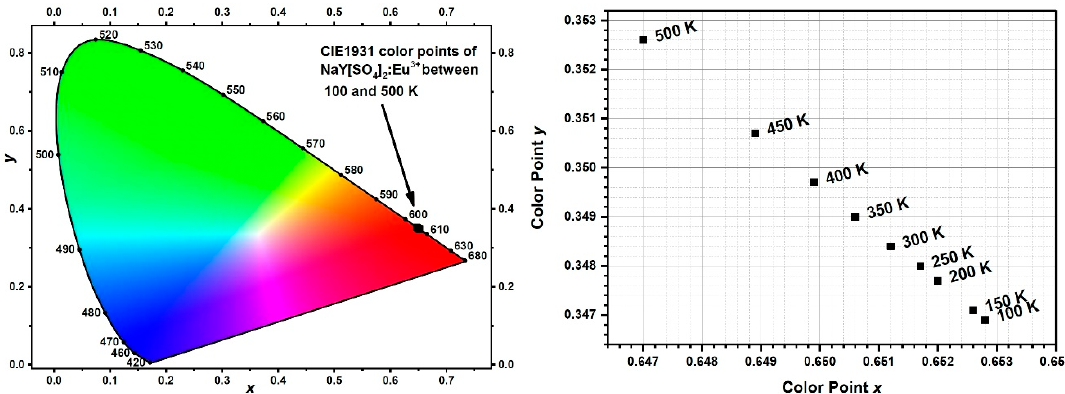
Figure 15. Temperature-dependent CIE1931 color points of the anhydrous NaY[SO 4 ] 2 :Eu 3+ between 100 and 500 K upon 395 nm excitation ( left ) and zoom for the magnification of the red area of the color triangle ( right ).